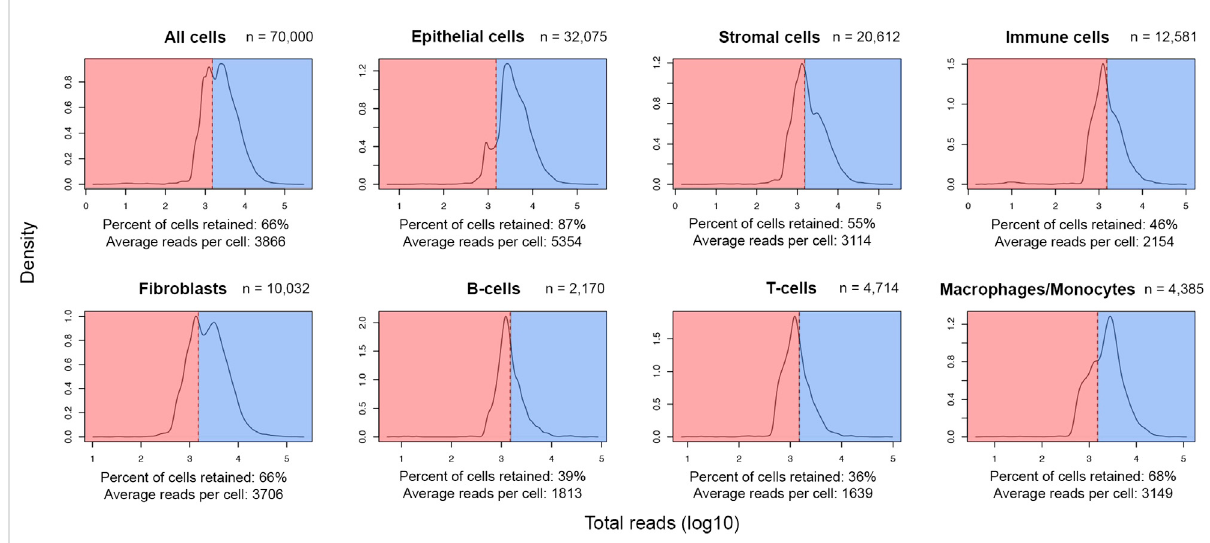
FIGURE 2 Post-QC retention rate varies across different lineages and cell types in the FELINE dataset. Density plots depict the reads-per-cell distribution across different lineages and cell types within a subsample of the original dataset ( n = 70,000). The initial QC count cut-off (1,500 reads), as dashed line, splits the fraction of cells considered as “ high-quality ” , highlighted in blue, from the cells considered as “ low-quality ” , highlighted in red, across different cell populations. The average count and the fraction of “ high-quality ” cells are annotated for each